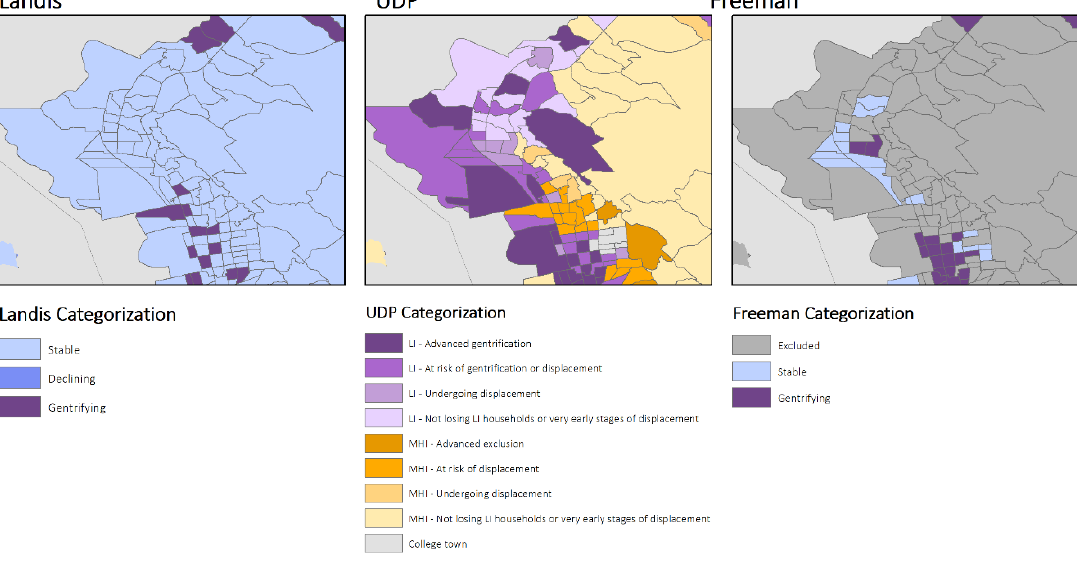
Figure 3. Spatial Representation of Gentrification in Richmond, California using the three different measures, Bay Area Census Tracts, 2000–2013.